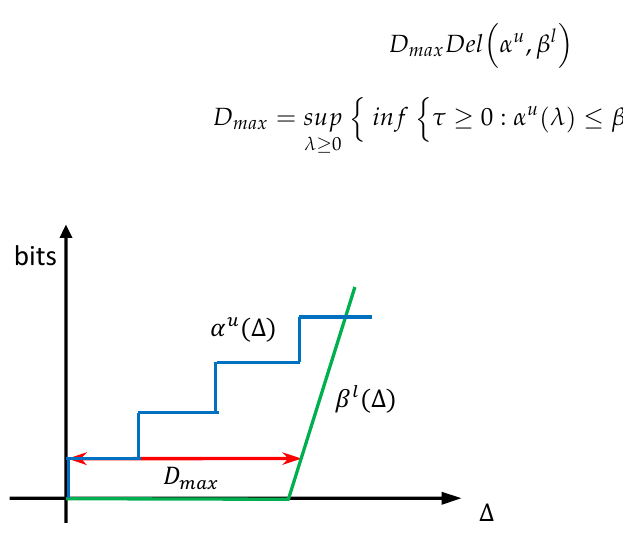
Figure 6. The worst-case latency bound using the network calculus method.